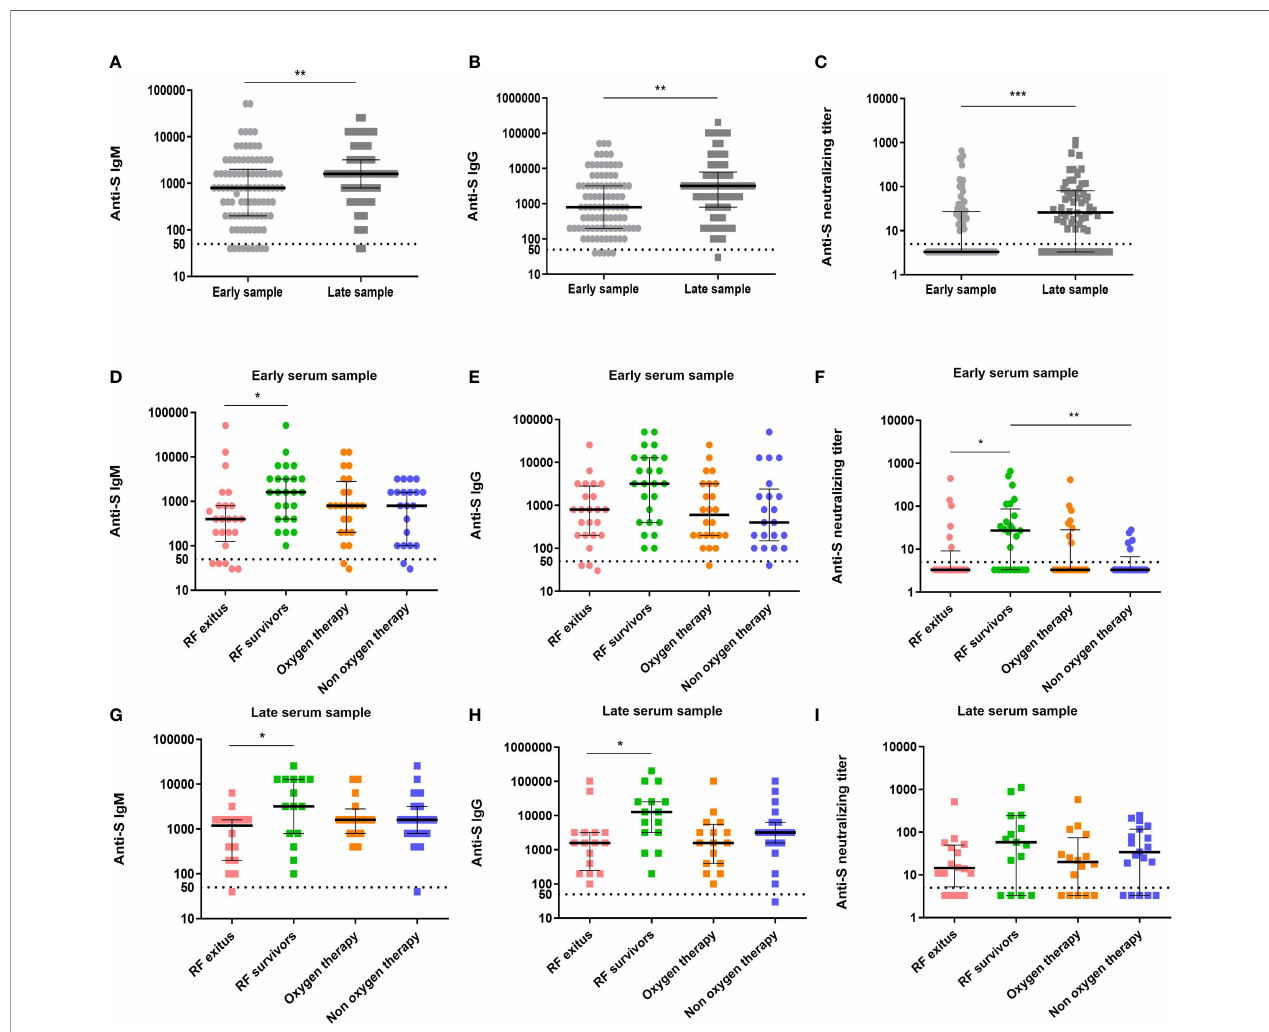
FIGURE 2 | Antibody levels and neutralizing activity against SARS-CoV-2 by sample precocity in total cohort and by clinical group. Anti-S IgM, anti-S IgG and neutralizing titers were determined in early serum samples (ES, collected in the fi rst nine days of symptoms) and in late serum samples (LS, collected from ten days of symptoms) for the total cohort (A – C) (light grey circles, n = 94 and dark grey squares, n = 66, respectively) and for the different disease severity groups (D – I) RF non-survivors (pink circles, ES: n = 24; pink squares, LS: n = 16), RF survivors (green circles, ES: n = 25; green squares, LS: n = 15), oxygen therapy (orange circles, ES: n = 24; orange squares, LS: n = 16) and non-oxygen therapy (blue circles, ES: n = 21; blue squares, LS: n = 19). Cutoff value to determine positive (above) and negative (below dashed line) samples is indicated and black lines represent medians and interquartile range. Statistical analysis were performed using Mann-Whitney U test and Kruskall-Wallis and Dunn ’ s Multiple Comparison tests. * p < 0.05 ** p < 0.01 and *** p < 0.001. RF indicates respiratory failure. Y axis is represented by logarithmic